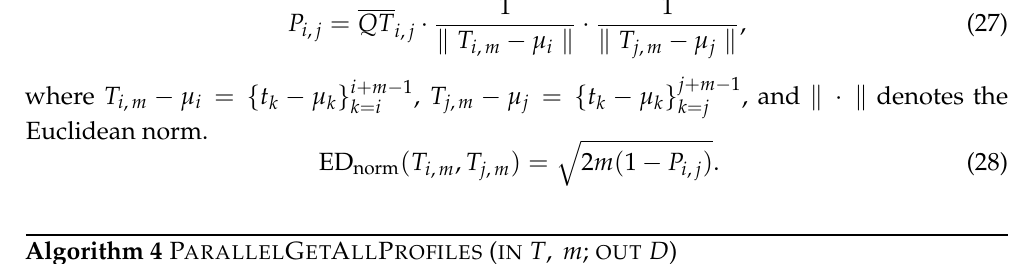
Algorithm 4 P ARALLEL G ET A LL P ROFILES ( IN T , m ; OUT D )